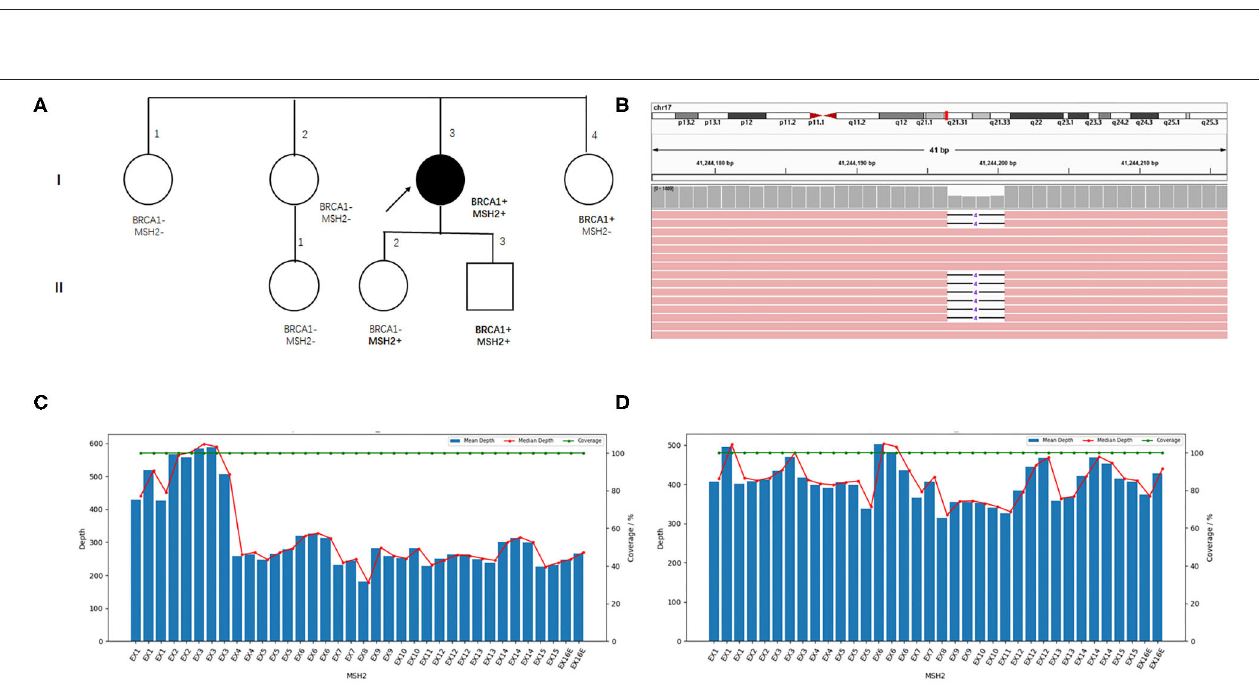
FIGURE 1 | Pathological findings. (A) H&E staining demonstrated the presence of both serous and endometrioid components. Immunohistochemistry staining of MSH2 (B) and MSH6 (C) (100x magnification).